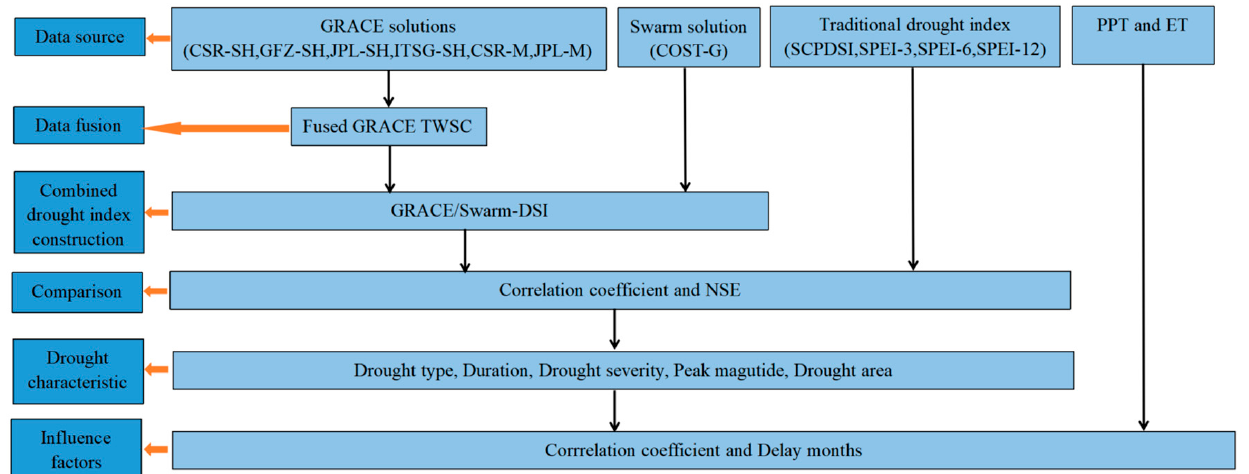
Figure 2. Flowchart of the drought monitoring and characterization.